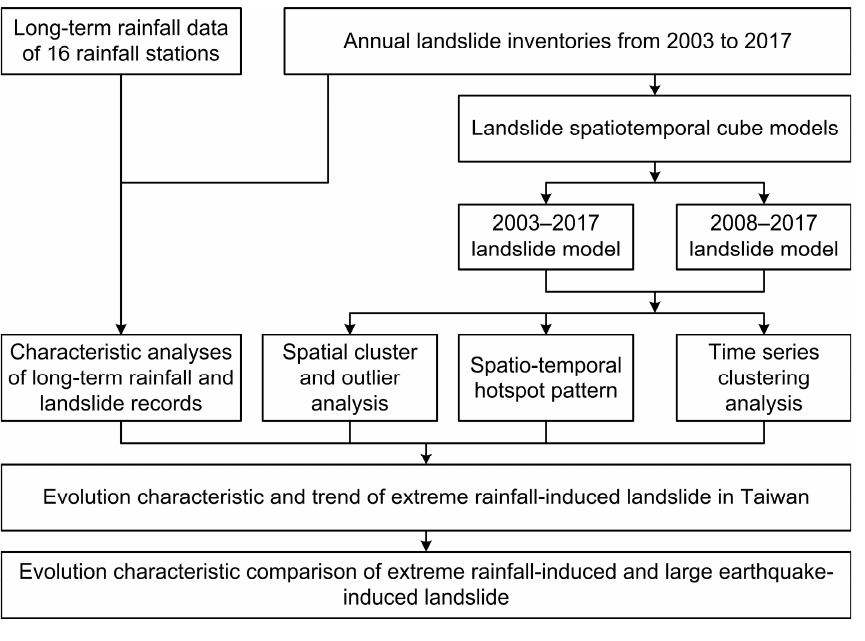
Figure 3. The fl ow chart in the study. Figure 3. The flow chart in the